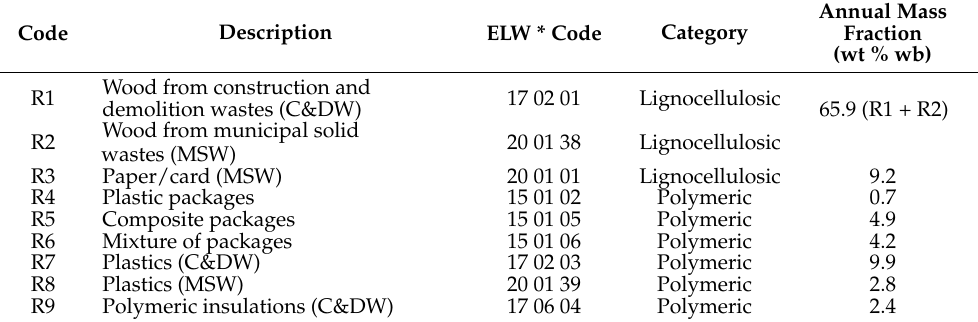
Table 1. Residues used in the gasification